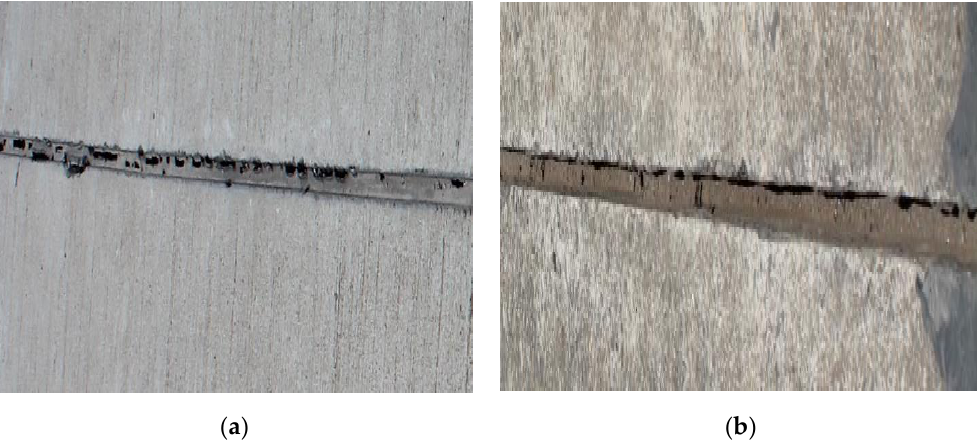
Figure 17. The appearance of the conventional joint sealants after one year. ( a ) The military airport in Tibet. ( b ) The military airport in Guangdong province.